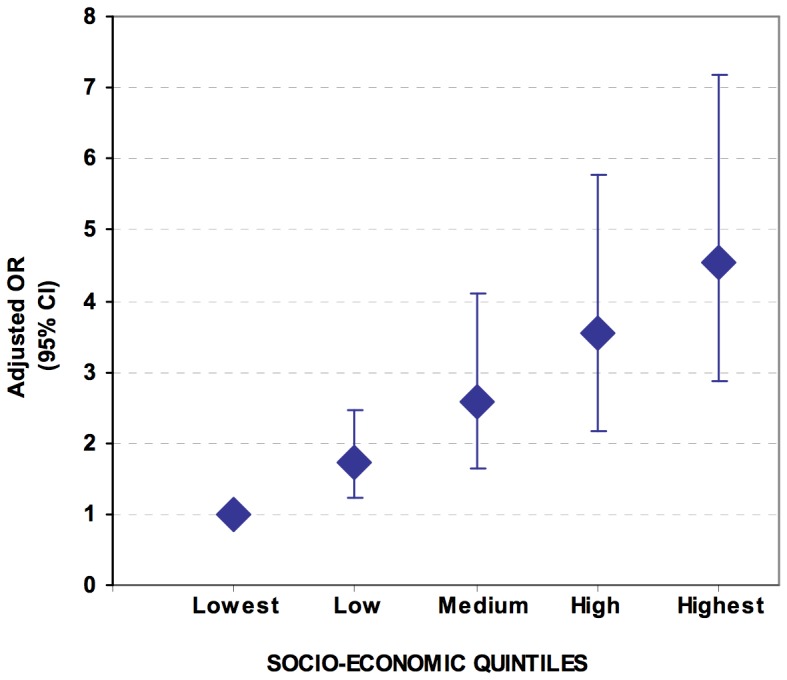
Odds ratios of belonging to hospital population compared to District population by socio-economic quintiles, with respective 95% confidence intervals.Iringa District, Tanzania. 2009–2012.